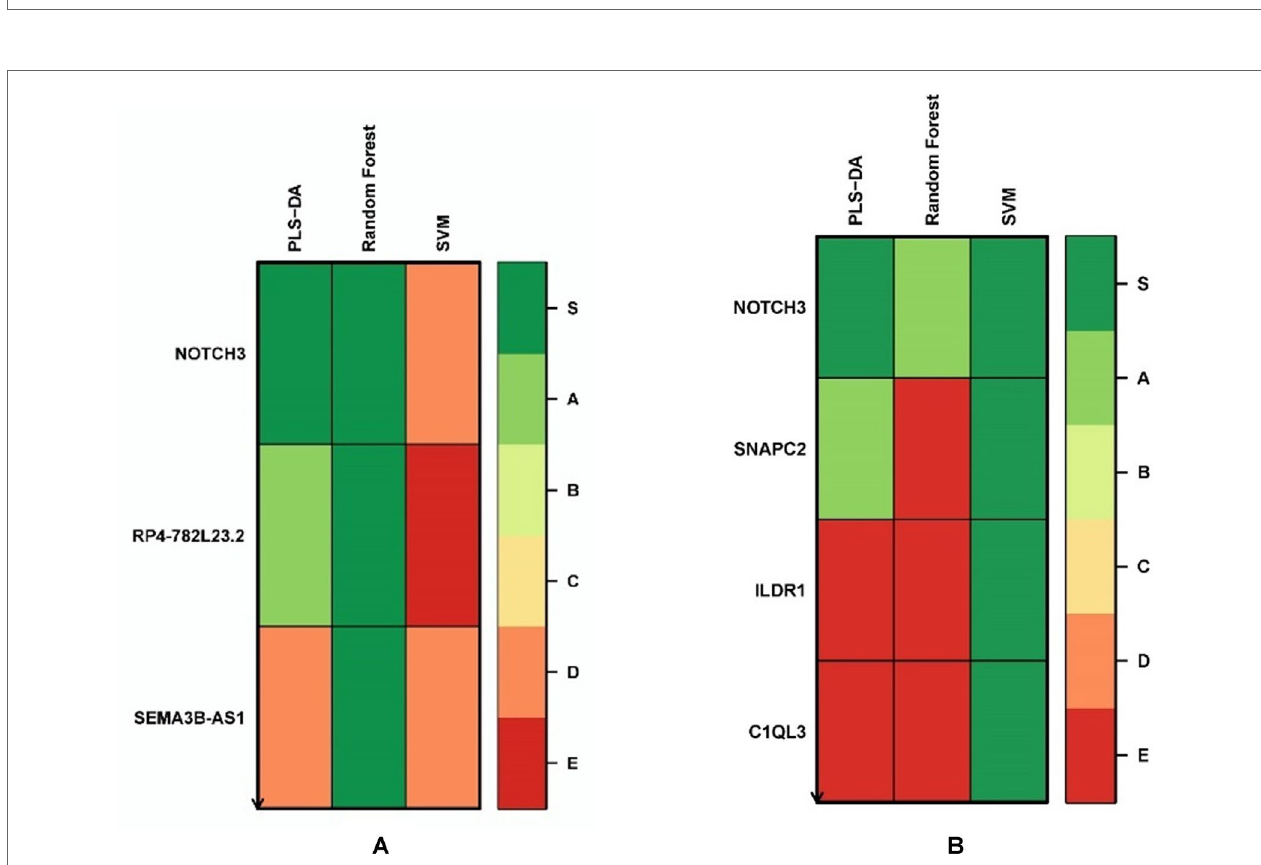
FIGURE 2 | Gene tier plot from Biosigner using transcriptomics data from the experiments using: (A) all genes, (B) protein-coding genes only; S, signature genes; A–E=A is a higher tier, and E is a lower